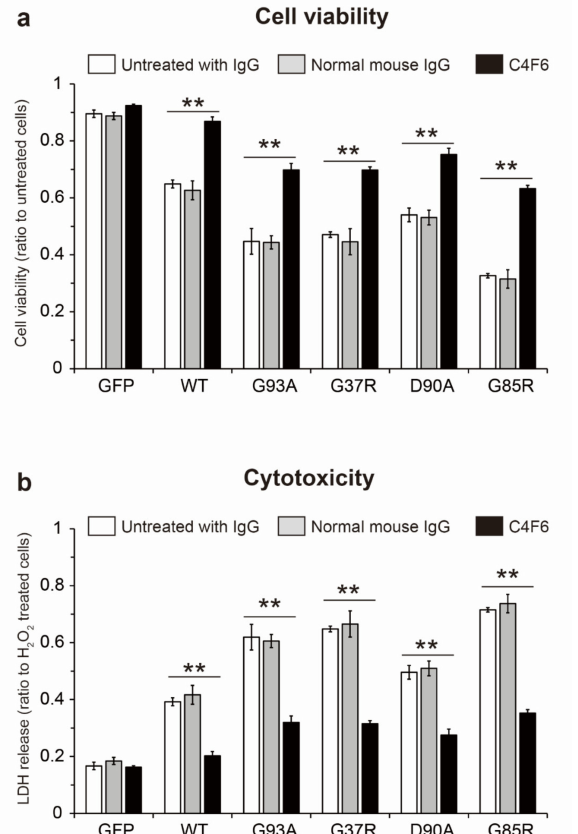
Figure 7. The conditioned medium containing extracellular misfolded metal free, disulfide oxidized superoxide dismutase 1 (apo-SOD1 S-S ) exerted cytotoxicity to motor neuron-like cells. (white) NSC- 34 cells expressing green fluorescence protein (GFP) untagged human wild-type SOD1 (hSOD1 WT ) were exposed to conditioned medium from NSC-34 harboring hSOD1-GFP containing misfolded apo- SOD1 S-S for 24 h. Cell viability and cytotoxicity were assessed using ( a ) a Cell Counting Kit 8 assay and ( b ) a lactate dehydrogenase (LDH) release assay, respectively. (black) Extracellular misfolded apo-SOD1 S-S was removed from the conditioned medium by immunoprecipitation with C4F6. (gray) As a control, the medium was immunoprecipitated with normal mouse IgG. In the data set of cell viability, the results are expressed as the cell viability of recipient cells relative to that of untransfected cells, which were incubated with normal culture medium, Dulbecco’s modified Eagle’s medium and F-12 with GlutaMAX™ containing 1% ( v / v ) fetal bovine serum and 0.1 mM non-essential amino acids, instead of the conditioned medium. In the data set of cytotoxicity, the results are given as the amounts of released LDH to the medium relative to that of cells exposed to 100 µ M H 2 O 2 for 24 h. All data are expressed as the mean ± SD, n = 3 for each treatment. Statistical analysis was performed using one-way ANOVA followed by the Tukey–Kramer post hoc test. ** p <